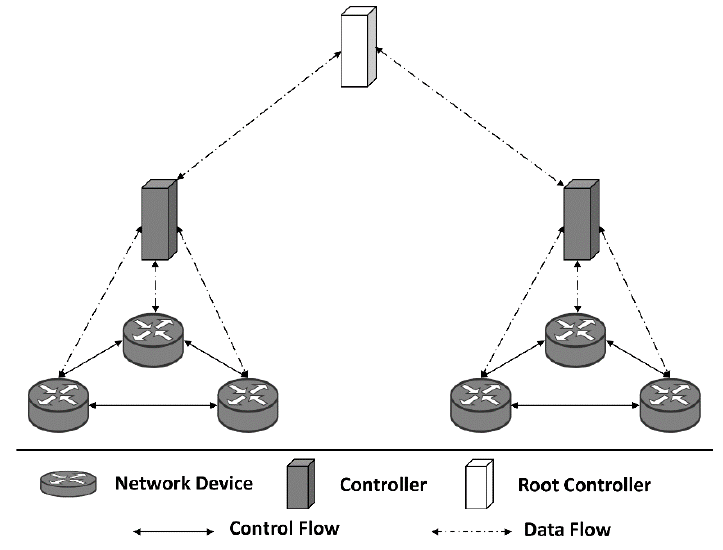
Figure 5. Distributed Hierarchical Controllers Design .